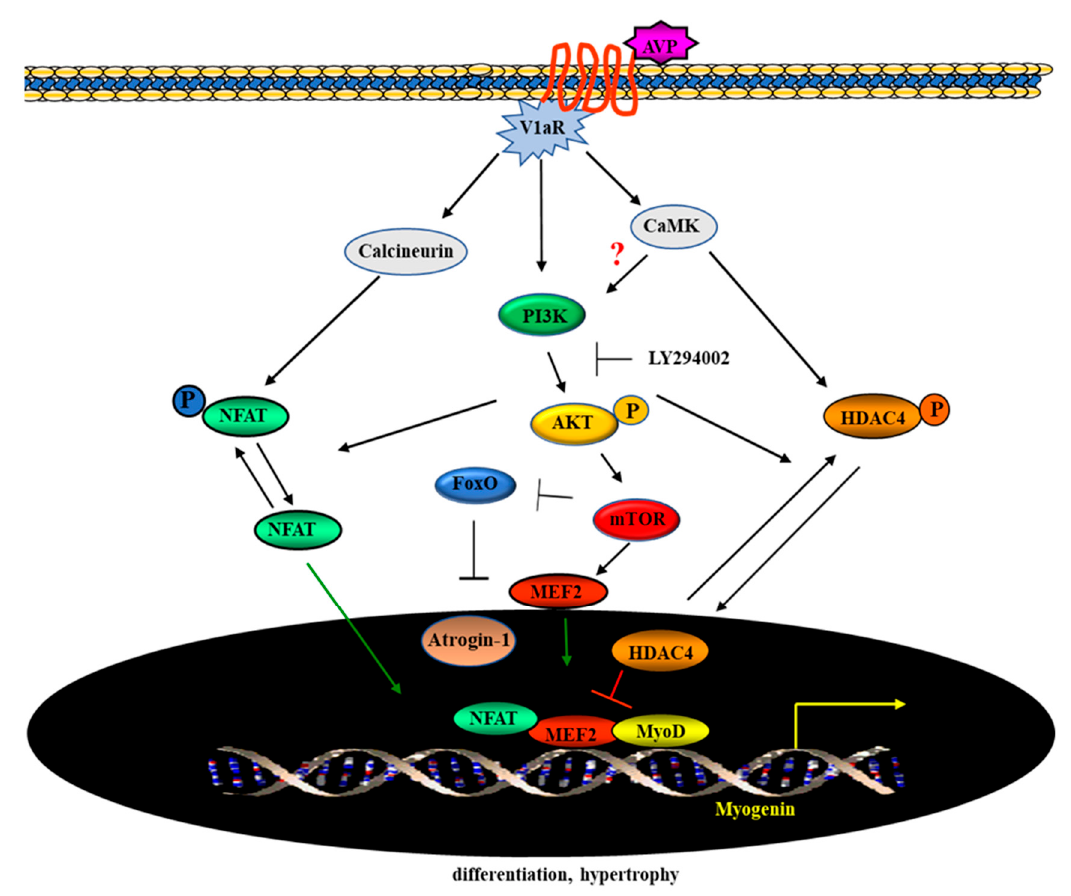
Figure 8. Schematic representation of signaling pathways involved in the AVP-dependent myogenic differentiation. The stimulation of AVP-V1aR signaling in myogenic cells results in the activation of the CaMK and the calcineurin pathways. The AVP-dependent combined activation of both pathways results in the formation of multifactorial complexes on the promoters of muscle-specific genes and strongly stimulates myogenic differentiation. The V1aR is a G-protein coupled receptor, whose occupancy activates PI3K. Inhibition of PI3K/Akt signaling by LY294002 results in mTOR, MEF2, and myogenin downregulation, affects the cellular localization of MEF2 preventing its nuclear translocation, upregulates the expression of FoxO3a leading to the activation of ubiquitin ligase atrogin-1, thus impinging upon the AVP-dependent myogenic differentiation. Additionally, the inhibition of the PI3K pathway by LY294002 represses the AVP-dependent HDAC4 nuclear export and, consequently, hampers the binding of multifactorial complexes (which include NFATc3 and MEF2) on the promoter region of muscle-specific genes, impinging on the full development of the differentiation program. Of note, recent evidence highlights that the Ca 2+ -dependent activation of the CaMK pathway stimulates Akt/mTOR signaling in normal and neoplastic B-lymphoid cells, suggesting a crosstalk between these signaling which may potentiate the myogenic effect of AVP (T- bars represent inhibition).